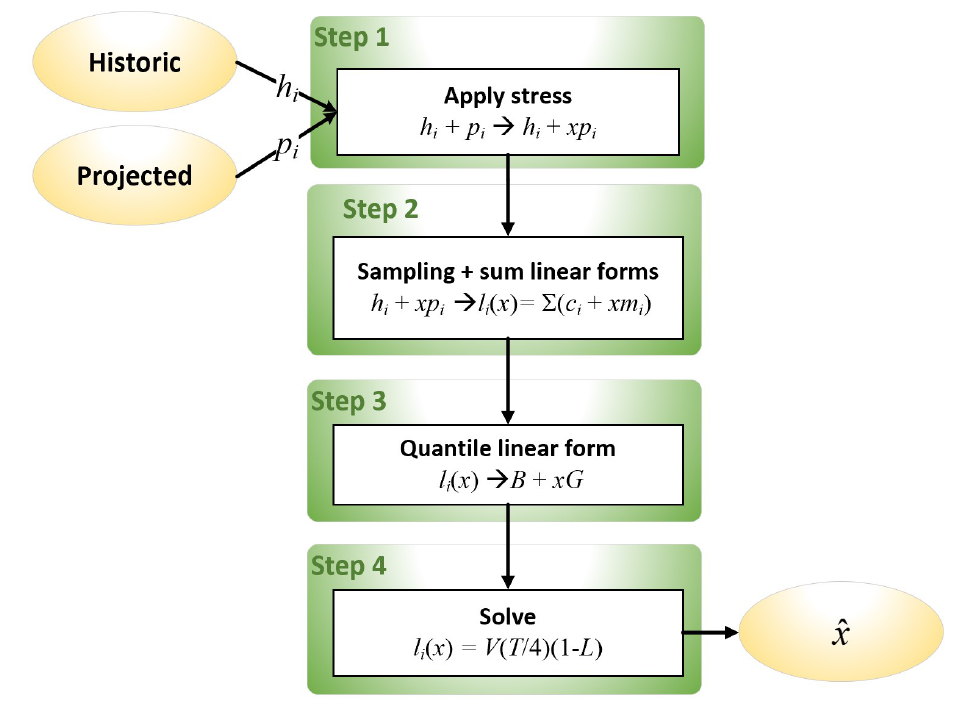
Figure 2. Major steps in Algorithm SymbolicLinear